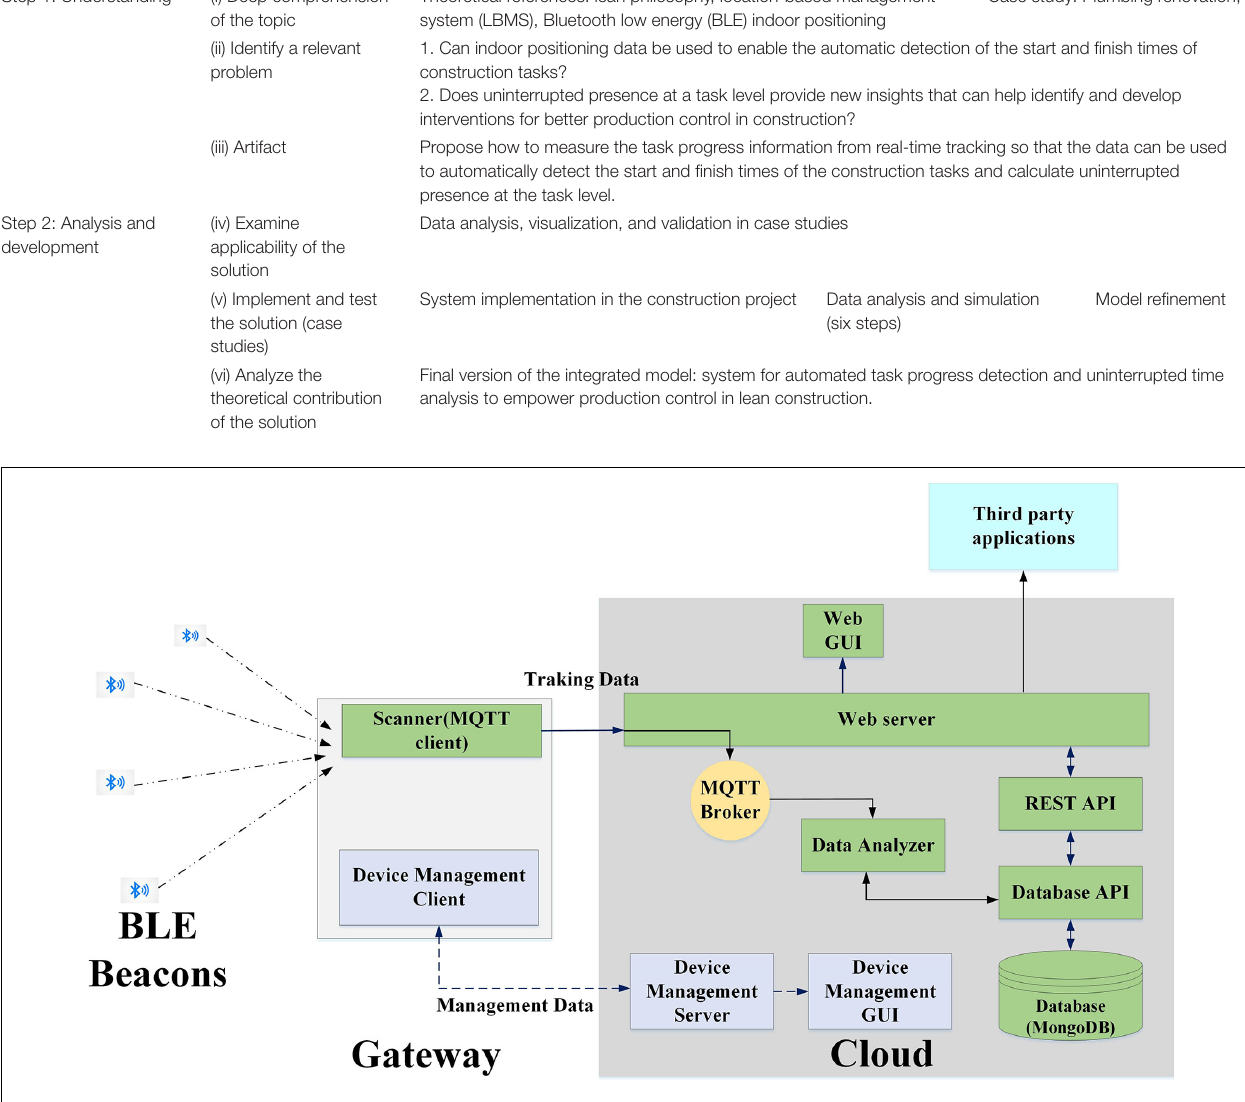
those signals using the Message Queuing Telemetry Transport (MQTT) protocol. The Received Signal Strength